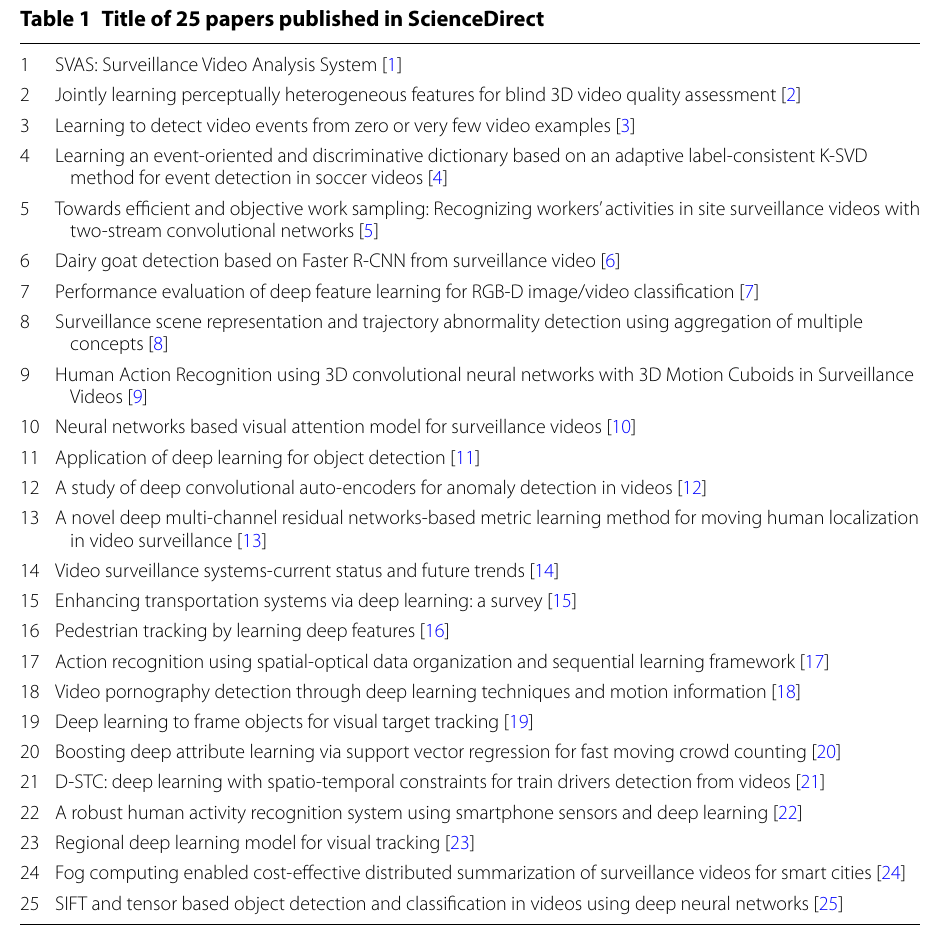
Table 1 list title of 25 papers published under same area. Table 2 gives the list of journals in ScienceDirect where above mentioned papers are published.